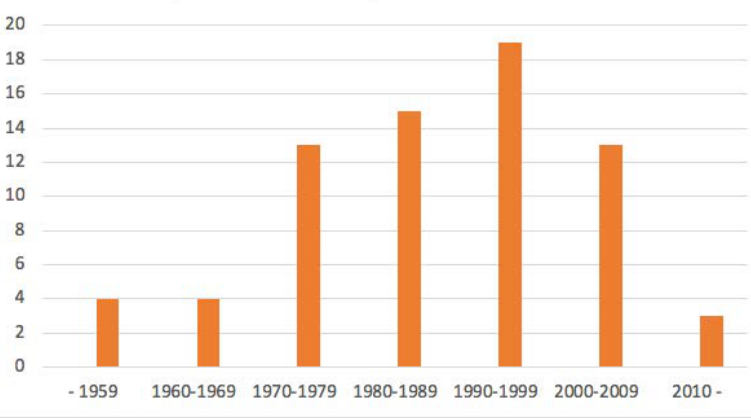
Figure 2 . Open universities periods